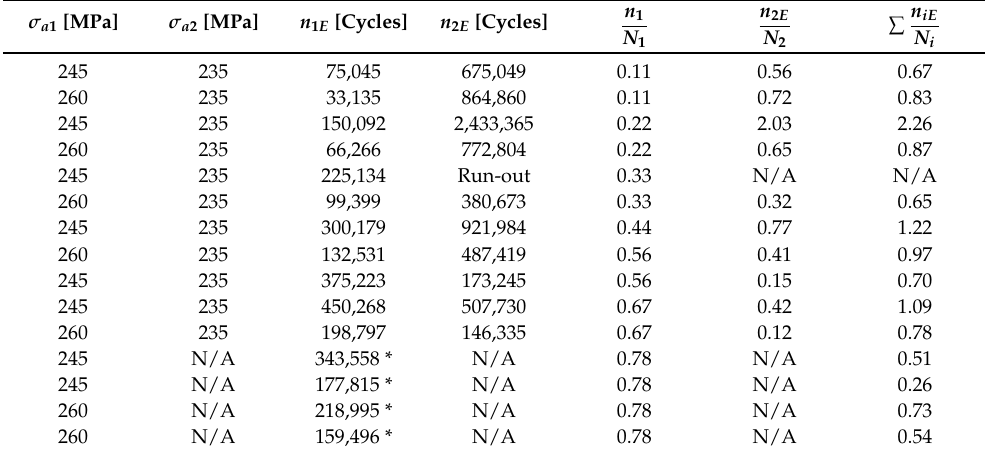
Table A4. Experimental results H–L block loading, specimens extracted from the rolling direction.